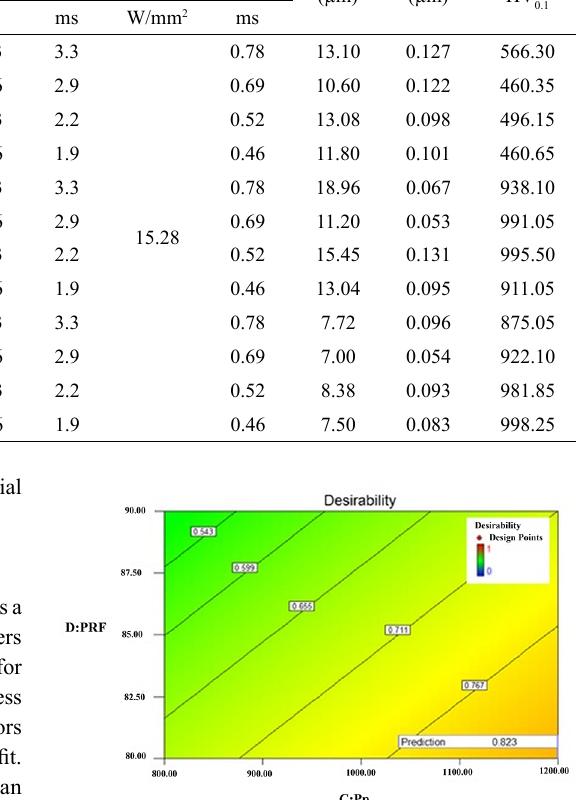
Table 3. Surface roughness, depth and hardness of clad zone laser surface cladding range spot sizes 1 mm. Num.